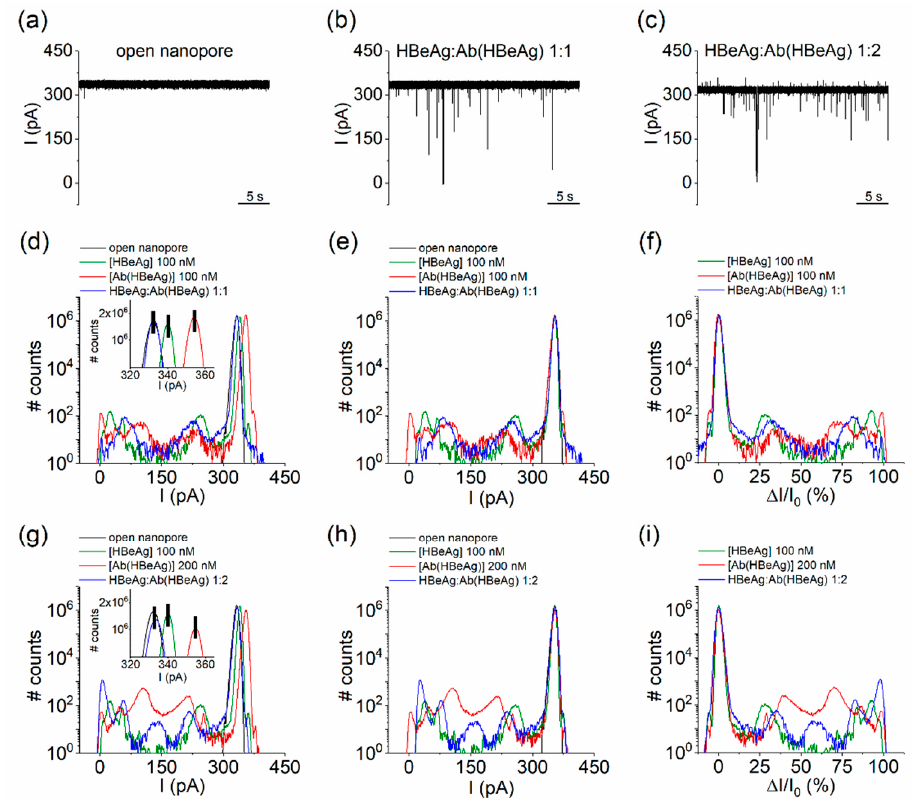
Figure 4. Detection of HBeAg–Ab(HBeAg) complexes with the α -HL nanopore. ( a – c ) Interaction between α -HL and nonincubated, cis -side-added HBeAg and Ab(HBeAg) mixed at a 1:1 (100 nM:100 nM) and 1:2 (100 nM:200 nM) molar ratio generate solid ionic currents blockades across the open α -HL nanopore at an applied voltage ∆ V = + 180 mV. ( d ) All-points histograms showing the distinct conductive states of α -HL nanopore, while interacting with the cis -side-added HbeAg, Ab(HBeAg), or HBeAg–Ab(HBeAg) complexes (1:1 molar ratio). In the inset we represent a zoomed-in excerpt evidencing the experimental shift in the open pore current through the nanopore in either case (see also text). ( e ) Shift-corrected histograms, all aligned to a similar value corresponding to the open nanopore current. ( f ) The shift-corrected, all-points histograms transformed in terms of percent relative current blockades (% , where ∆ I is the current magnitude of a blockade substate relative to the open nanopore current I o ). ( g ) All-points histograms showing the distinct conductive states of α -HL nanopore, while interacting with the cis -side-added HbeAg, Ab(HBeAg), or HbeAg–Ab(HBeAg) complexes (1:2 molar ratio). As above, in the inset we represent an excerpt displaying the experimental variability in the open pore current through the nanopore during such measurements. ( h ) Shift-corrected histograms, all aligned to a similar value corresponding to the open nanopore current. ( i ) The shift-corrected, all-points histograms transformed in terms of percent relative current blockades (% I o